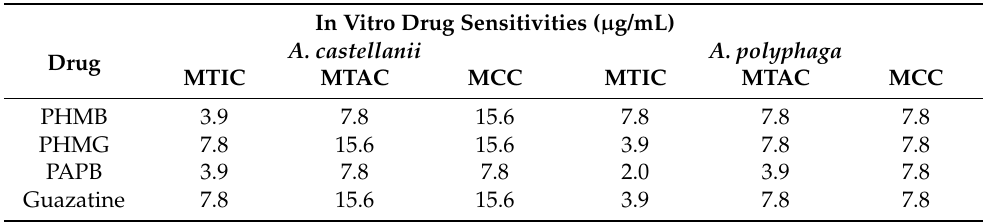
Table 1. The minimum trophozoite inhibitory concentration (MTIC), minimum trophozoite amoebici- dal concentration (MTAC), and minimum cysticidal concentration (MCC) of PHMB, PHMG, PAPB, and guazatine against A. castellani and A. polyphaga